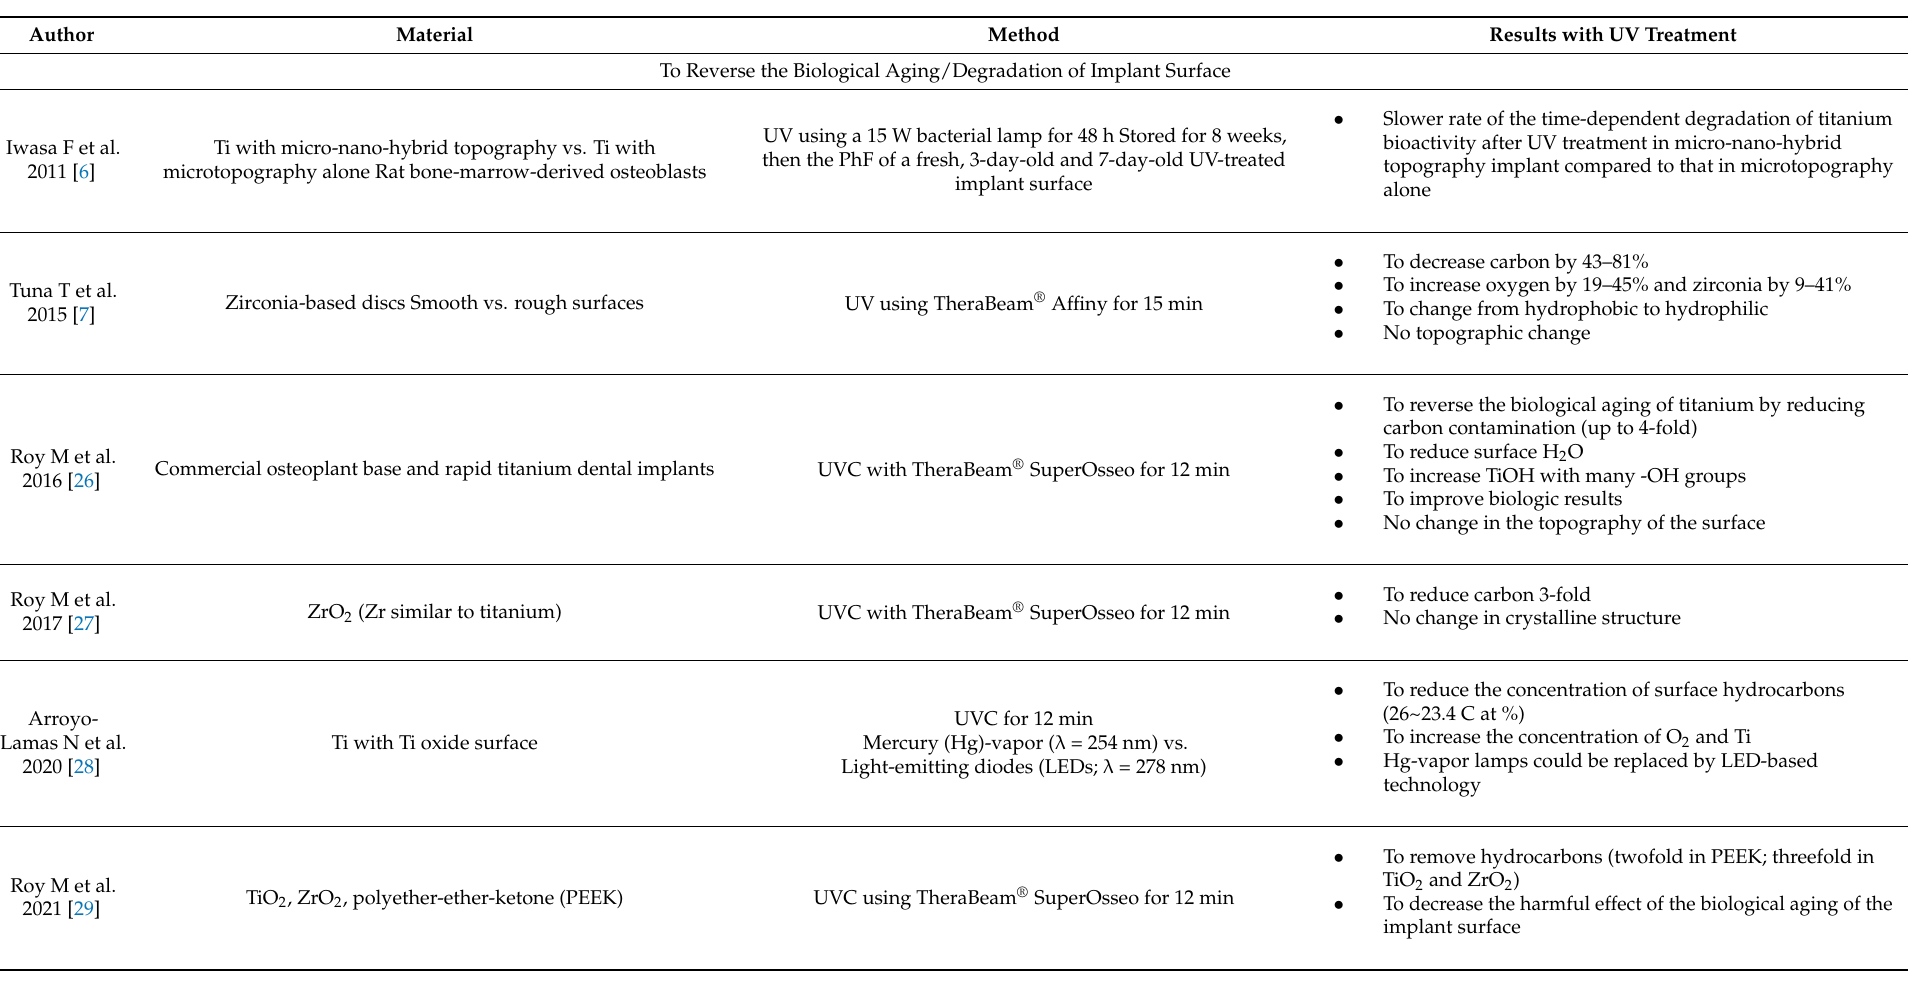
Table 1. The effect of photofunctionalization on dental implants in